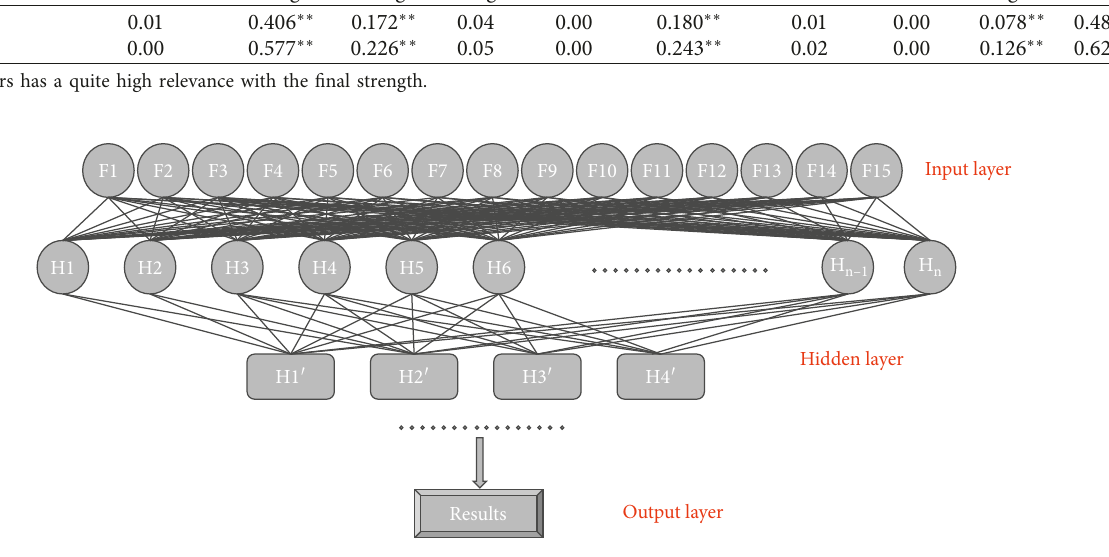
Figure 3: Backpropagation neural network abstract.